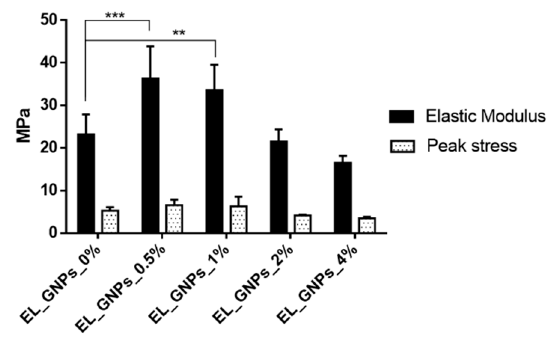
Figure 9. Elastic modulus and peak stress of neat EL_GNPs_0% and composite EL_GNPs matrices. Results are expressed as mean ± SD ( n = 3). Tukey’s multiple comparisons test reveals statistic differences for (**) p value < 0.01, (***) < 0.001.